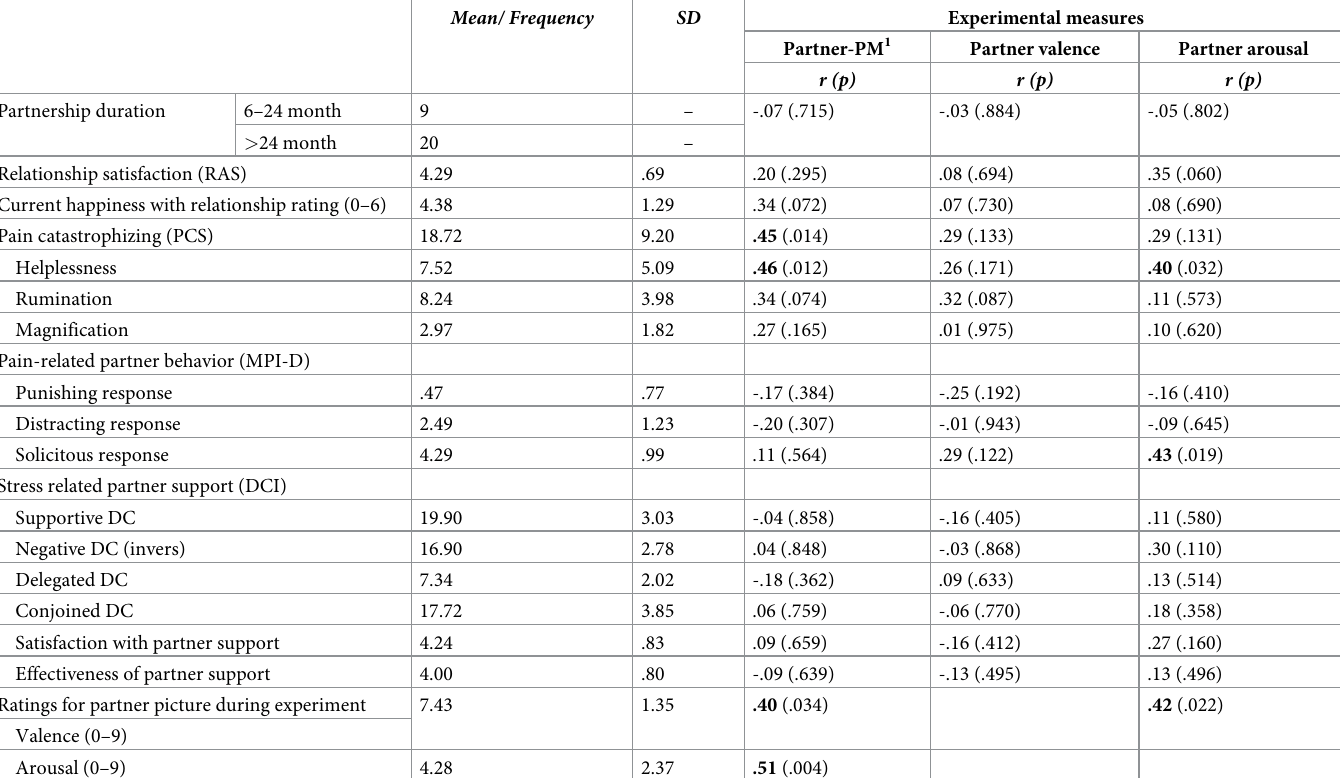
Table 1. Sociodemographic characteristics, questionnaire data and valence and arousal ratings of the partner picture and their correlation with experimental mea- sures of partner pain modulation